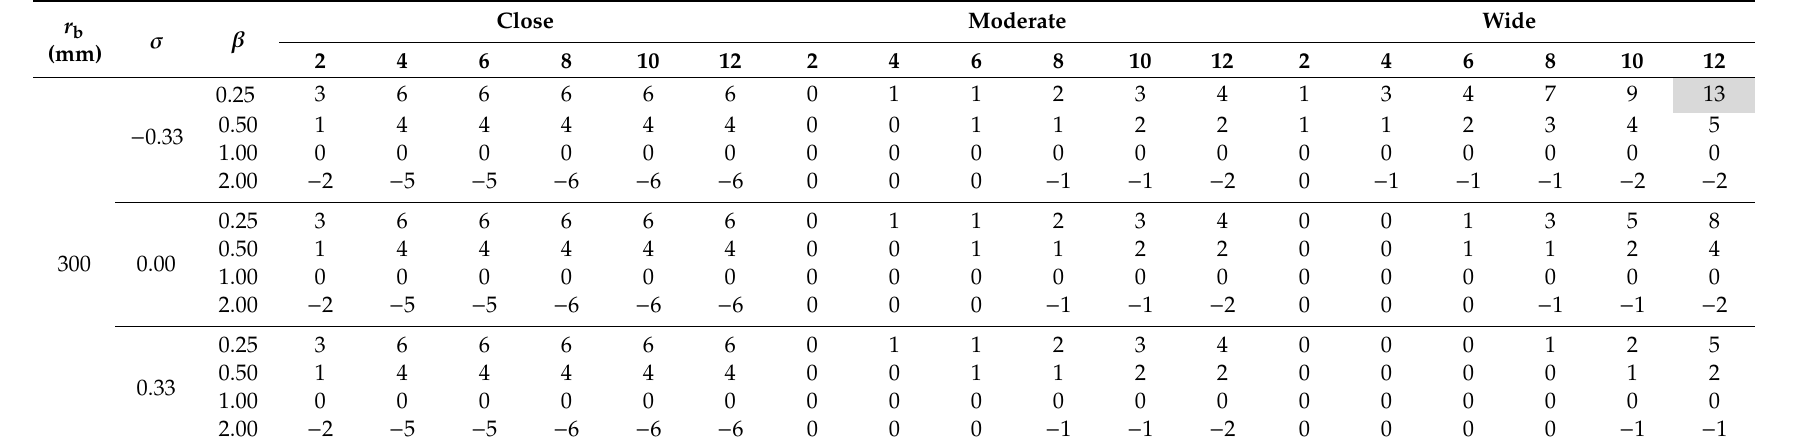
Table 3. Relative error ∆ R b0 ( N , r b , r c , r p , σ , β ) in percent for N = 2 to 12, and r c = r c,min (close spacing), 2 r b / 3 (moderate spacing), and r b − r p (wide spacing) a . The pipe radius r p is 0.02